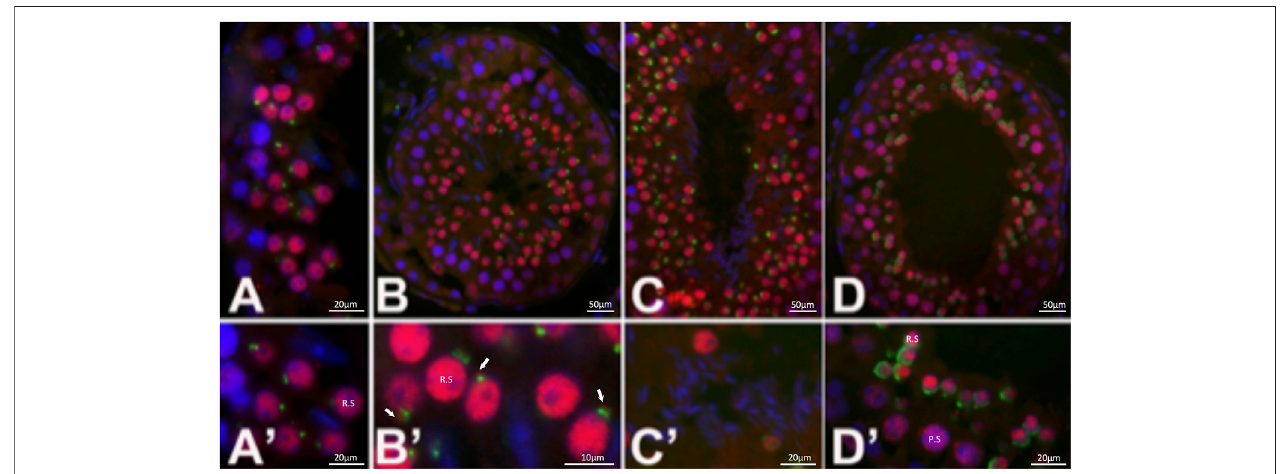
FIGURE3| DistributionofEML5(red)inbulltestis.EML5isdetected inearlysteproundspermatid(R.S.)nuclei (A,A 9 ,B,B 9 ) aswellasinadistinctfocusadjacentto the developing acrosomal granule (B ’ ) ; arrows; green, acrosomal labeling with lectin PNA. Nuclear labeling persists throughout spermatid elongation (C,D) and the formation of the acrosomal cap but weakens in late steps of elongation and sperm nuclear shaping (C 9 ) . The earliest EML5 labeling was detectable in pachytene spermatocytes (P.S.) (D 9 ) , where it is inter-dispersed between condensed chromosomes. DNA was counterstained with DAPI (blue).